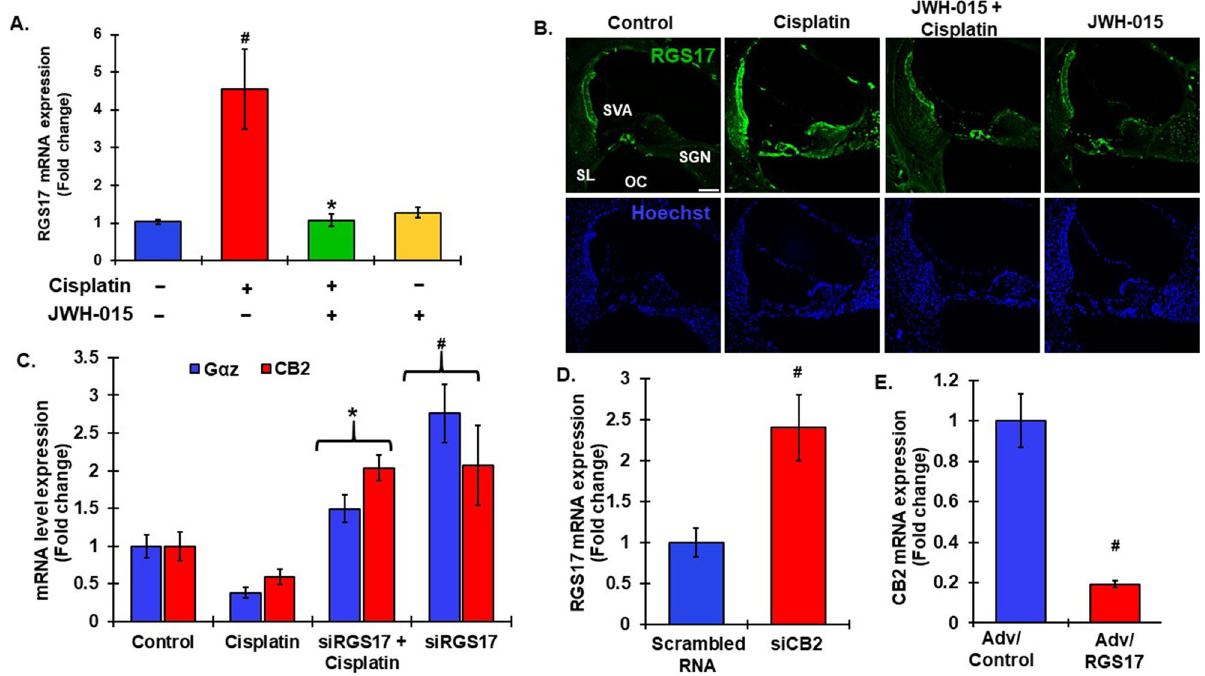
Figure 8. Reciprocal regulation between RGS17 and CB2 signaling. ( A ) Naïve male Wistar rats were treated with CB2 agonist, JWH-015 (0.815 µg/ear) by the trans-tympanic route prior to cisplatin (11 mg/kg, i.p) administration and cochleae were harvested after 3 days. RNA was extracted from the whole cochleae and processed for RT-qPCR. RGS17 expression was significantly elevated by cisplatin, but was significantly attenuated by pretreatment with JWH-015. #p < 0.05 versus control. *p < 0.05 versus cisplatin, N = 4, two way ANOVA. ( B ) The cochleae collected from same rats were fixed and processed for mid-modiolar sectioning and immunolabelled for RGS17. Cisplatin increased RGS17 immunoreactivity whereas activation of CB2R via JWH-015 reduced this fluorescence. Scale bar 50 μm. ( C ) siRNA against RGS17 , siRGS17 (0.9 µg/ear), was administered into the rat cochleae 48 h prior to cisplatin exposure. RT-qPCR analysis was performed on the cochleae collected from those treated animals to assess CB2 and Gαz expression. siRGS17 increased cochlear CB2 and Gαz expression whereas cisplatin treatment decreased it. Data indicates mean fold change in expression ± SEM, N ≥ 4, p < 0.01, *statistically significant difference from cisplatin treatments, # indicates statistically significant difference from vehicle control, two-way ANOVA. ( D ) Rats were administered either scrambled RNA (0.9 µg/ear) or siRNA against CB2 (siCB2R, 0.9 µg/ear) trans-tympanically. Cochleae were collected to perform RT-qPCR analysis. siCB2R treated rats showed significantly increased RGS17 mRNA expression. #p < 0.05 versus scrambled RNA. ( E ) Conversely, overexpression of RGS17 in the rat cochlea via administration of adenoviral vector significantly decreased CB2R expression. Data represents fold change ± SEM, N ≥ 5t-test p < 0.05, #indicates statistically significant difference from Adv vector